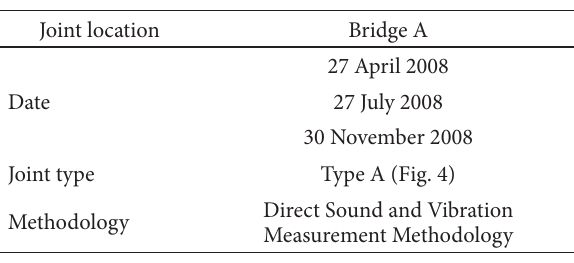
Table 2. Details of the measurements carried out on Bridge A